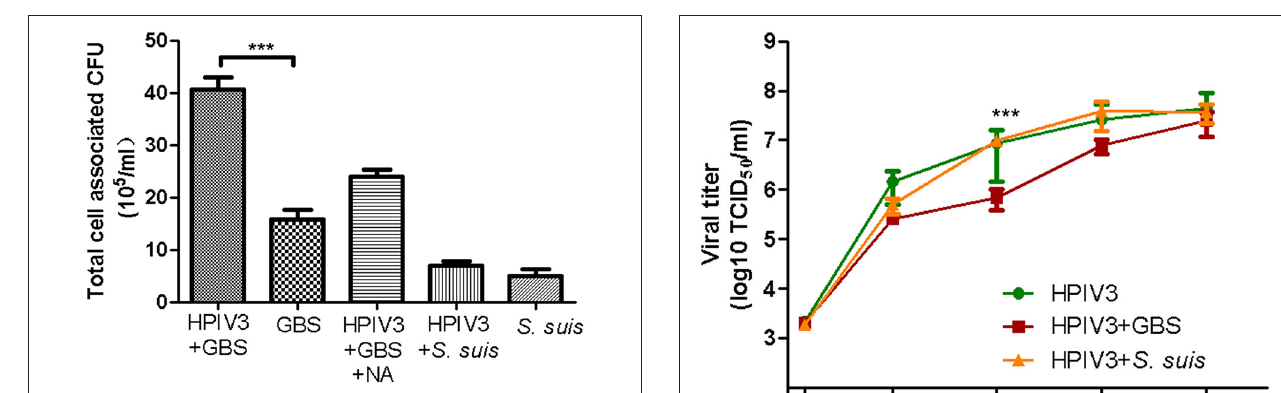
FIGURE 3 | Quantification of bacteria adhering to HPIV-infected HEp-2 cells. GBS (with or without NA-treatment) or S. suis were inoculated onto HEp-2 cells at 16h post infection by HPIV. Parallel experiments were performed on HEp-2 cells without virus infection. Total cell-associated bacteria were determined by serial plating on Columbia agar supplemented with 7% sheep blood. All experiments were repeated at least three times with duplicate samples. Statistical analysis was performed with one-way ANOVA, *** P < 0.001 . another 2 h at 37 ◦ C with either GBS or S. suis. After removal